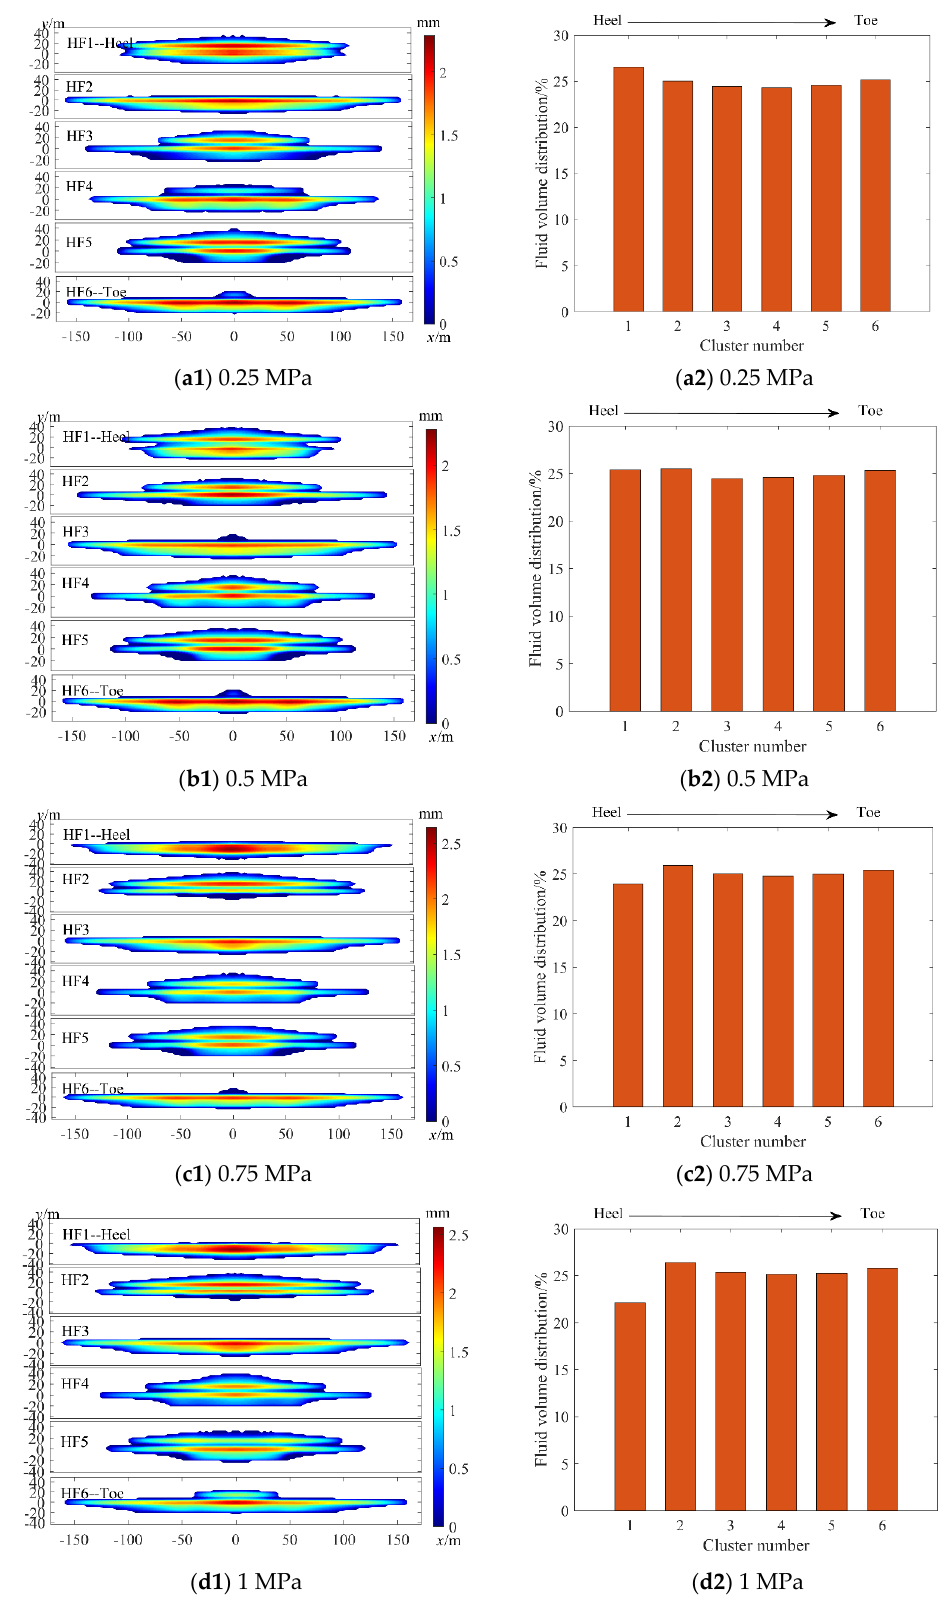
Figure 14. Patterns of and fluid allocation between fracture clusters at different stress differences between clusters.